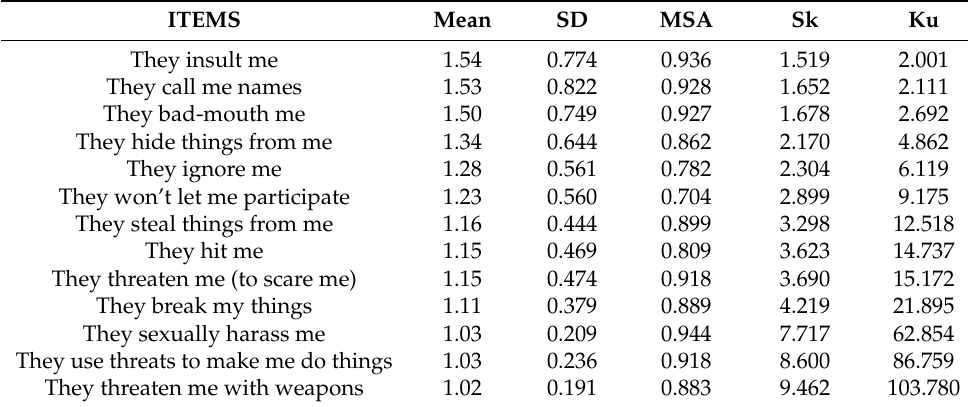
Table 2. Main descriptive statistics of the bullying victim detection scale.